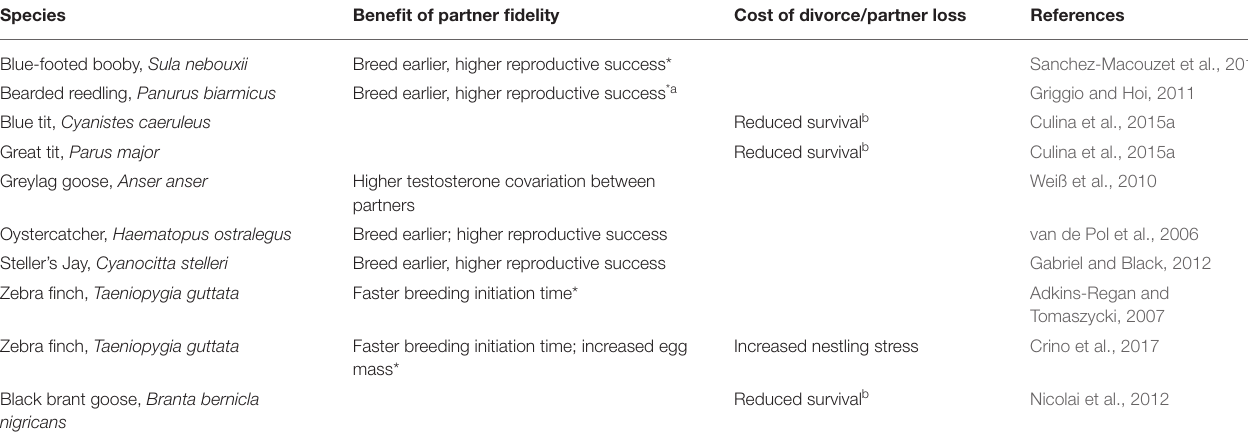
TABLE 1 | The value of remaining with a partner over multiple reproductive attempts, or the cost of divorcing or losing a partner.